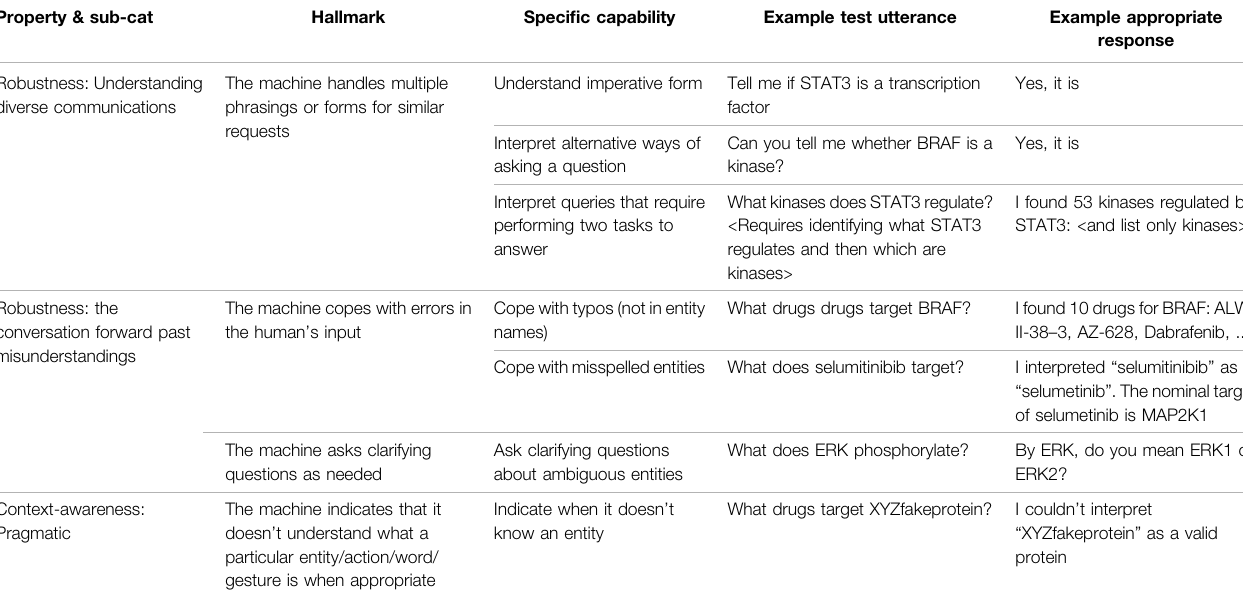
TABLE 1 | Examples of Hallmark-related capabilities assessed with test utterances during Bob ’ s development. Property &